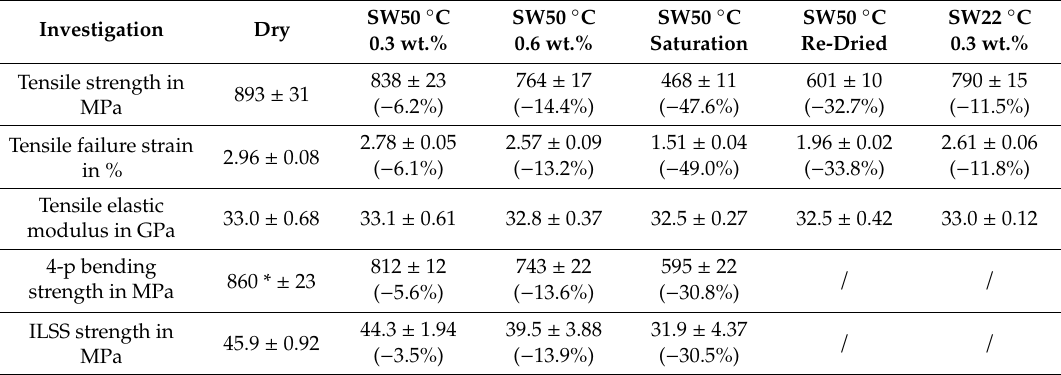
Table 3. Influence of variable wet ageing conditions and durations on the static mechanical properties of the glass fibre reinforced polymer (GFRP) laminate. * The dry four-point bending samples showed incorrect failure beneath the upper supports. Reference bending strength is expected to be higher than measured.